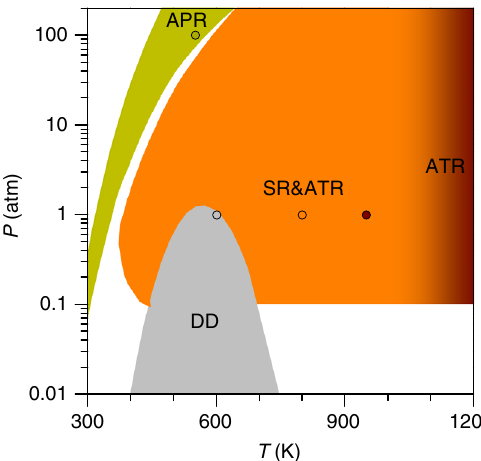
Fig. 1 Working conditions of reforming processes for hydrogen production. Shaded areas correspond to direct decomposition (DD), steam (SR), autothermal (ATR), and aqueous phase (APR) reforming. The points correspond to the conditions employed in the microkinetic